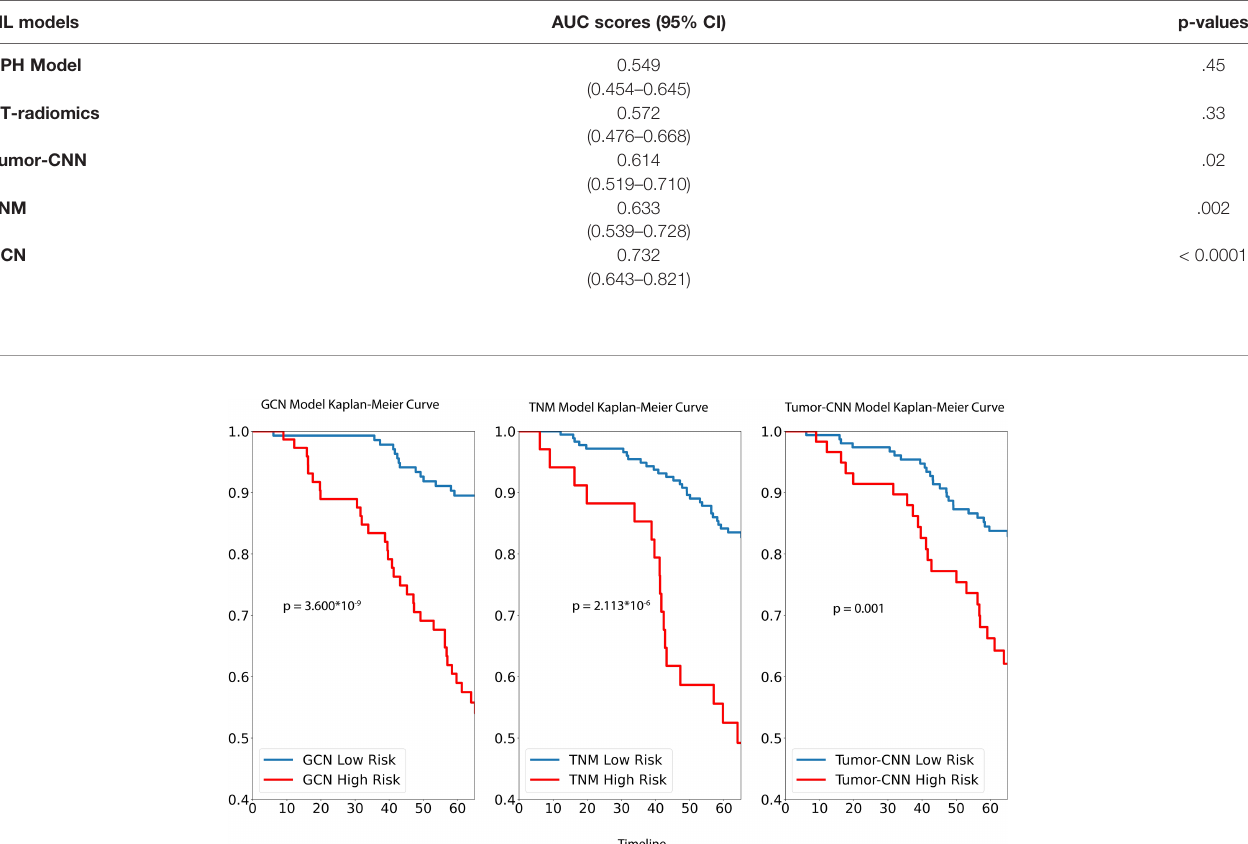
TABLE 2 | Performance for each model based on AUC scores and the Wilcoxon rank-sum